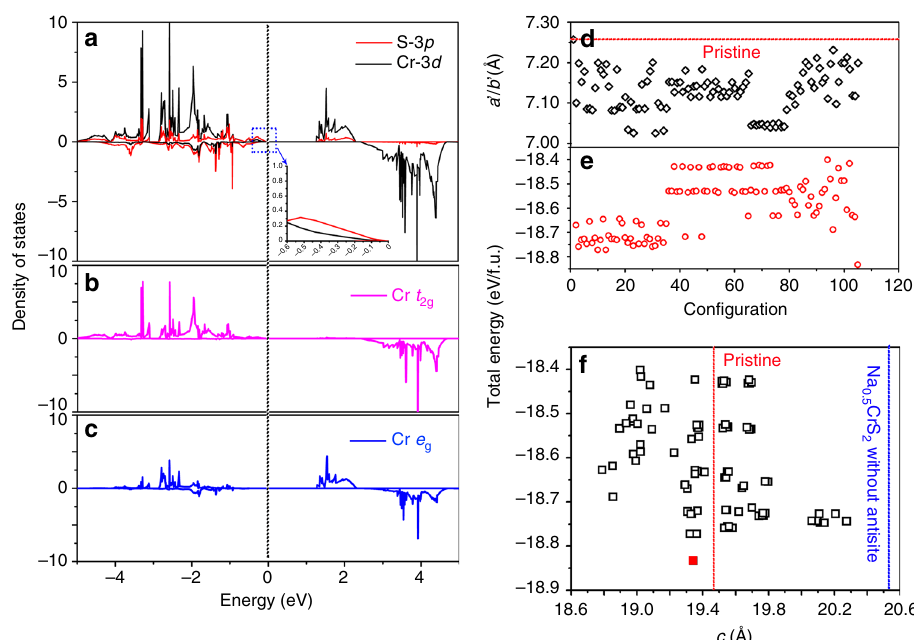
Fig. 6 DOS and Cr/V ′ Na antisite. a – c Density of states of NaCrS 2 . d , e Calculated lattice parameters a ′ /b ′ and total energies of 2 × 2 × 1 conventional cells and f dependence of calculated total energy of Na 0.5 CrS 2 with 1/6 Cr/V ′ Na antisite on lattice parameter c . The total energy unit is